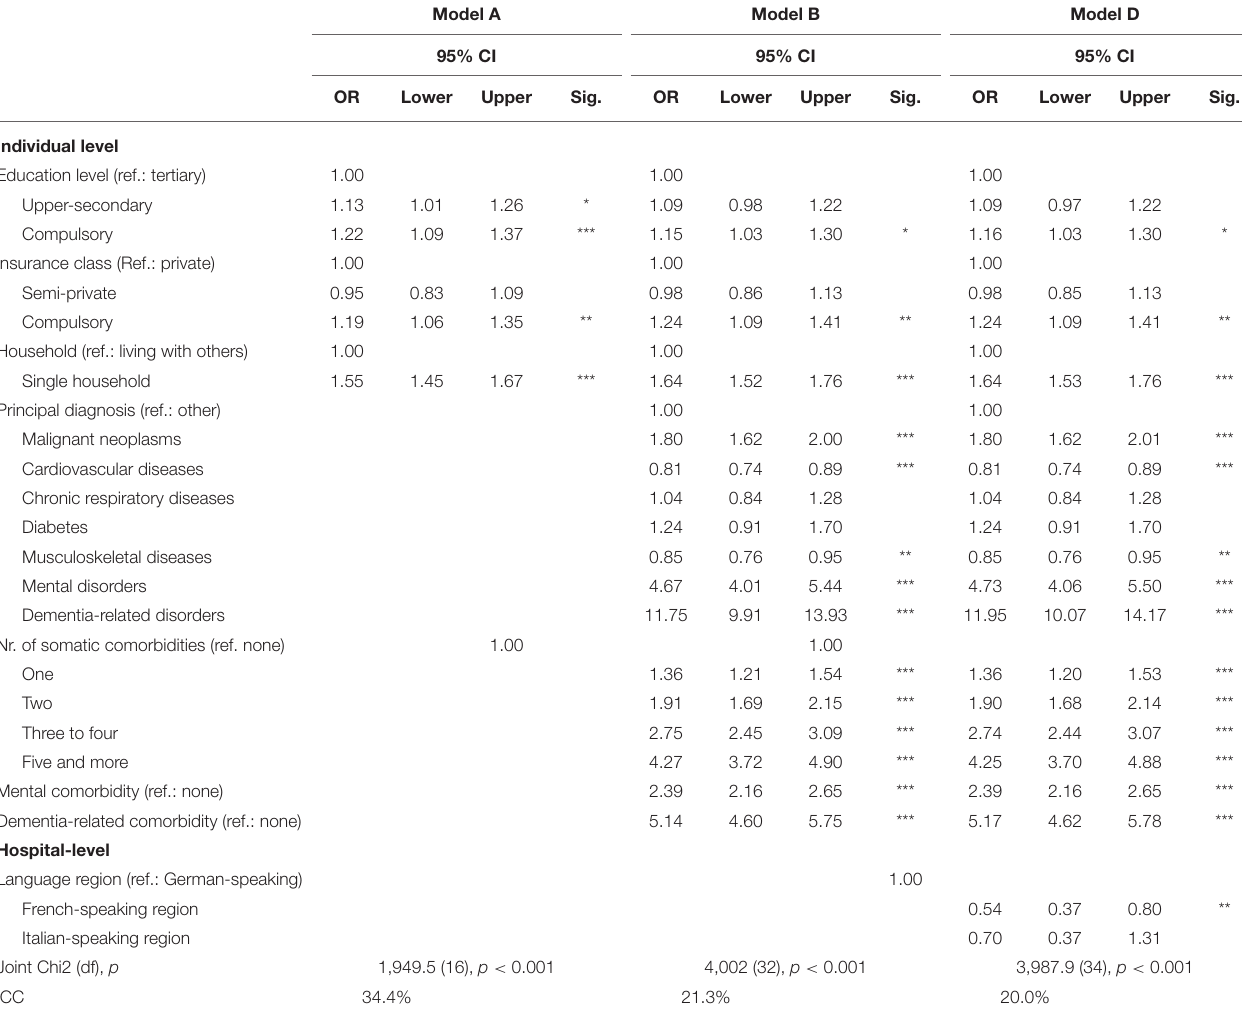
TABLE 3 | Results of the multilevel logistic regression models A, B and D with random intercepts; Estimations for social predictors, health covariates and regional variables (p, odds ratio and 95% confidence interval for single predictors; joint Chi2 test (df), p and ICC (intra-class-variance); Models adjusted for gender, age group, nationality, year of hospitalization and number of hospitalizations before